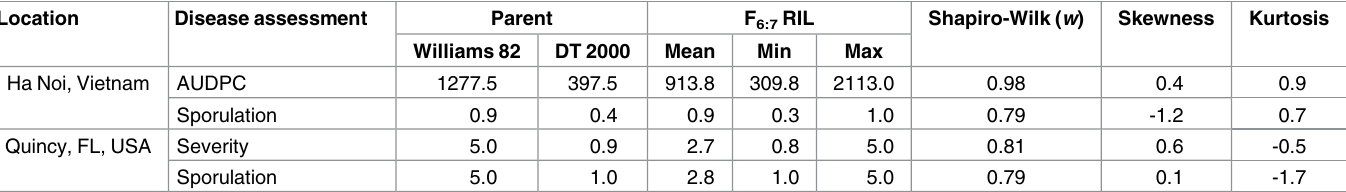
Table 3. Summaryof soybean rust statistics for area under disease progress curve (AUDPC) data for soybean rust, disease severity, and sporula- tion (%) on parental lines and 240 F 6:7 recombinant inbred lines derived from a Williams 82 × DT 2000 cross. The statistic Shapiro-Wilk ( w ), skewness, and kurtosis, were estimated to test the normalityof the